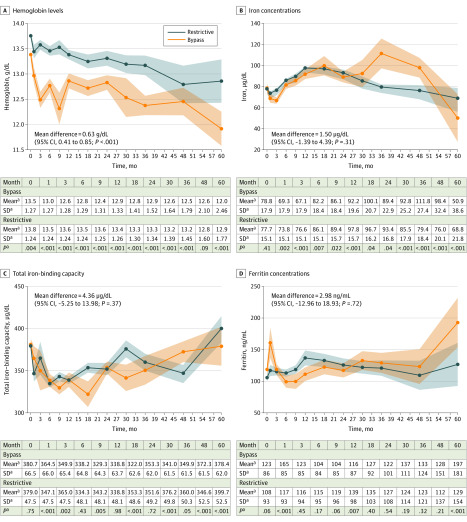
Five-Year Trajectories in Hemoglobin and Iron-related Serum ConcentrationsSI conversion factors: To convert hemoglobin to grams per liter, multiply by 10; iron to micromoles per liter, multiply by 0.179; and ferritin to micrograms per liter, multiply by 1.aEstimated margins and 95% CIs are plotted immediately after fitting inverse probability of treatment weighted linear mixed models conditioned on the treatment propensity score and additionally adjusted for sex. Restrictive includes patients who underwent laparoscopic sleeve gastrectomy; bypass includes patients who underwent laparoscopic Roux-en-Y gastric bypass or one-anastomosis gastric bypass.